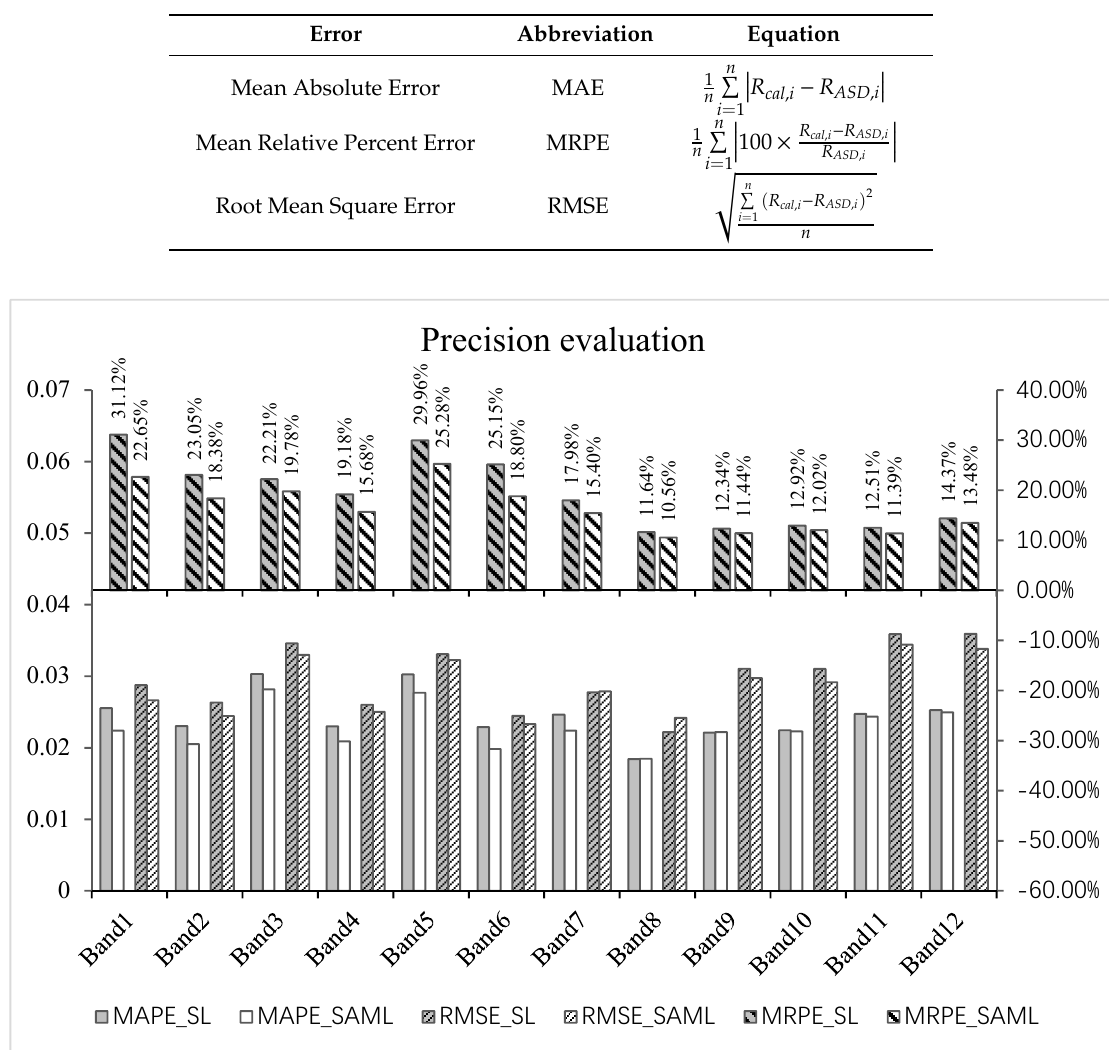
Table 6. Error equation.